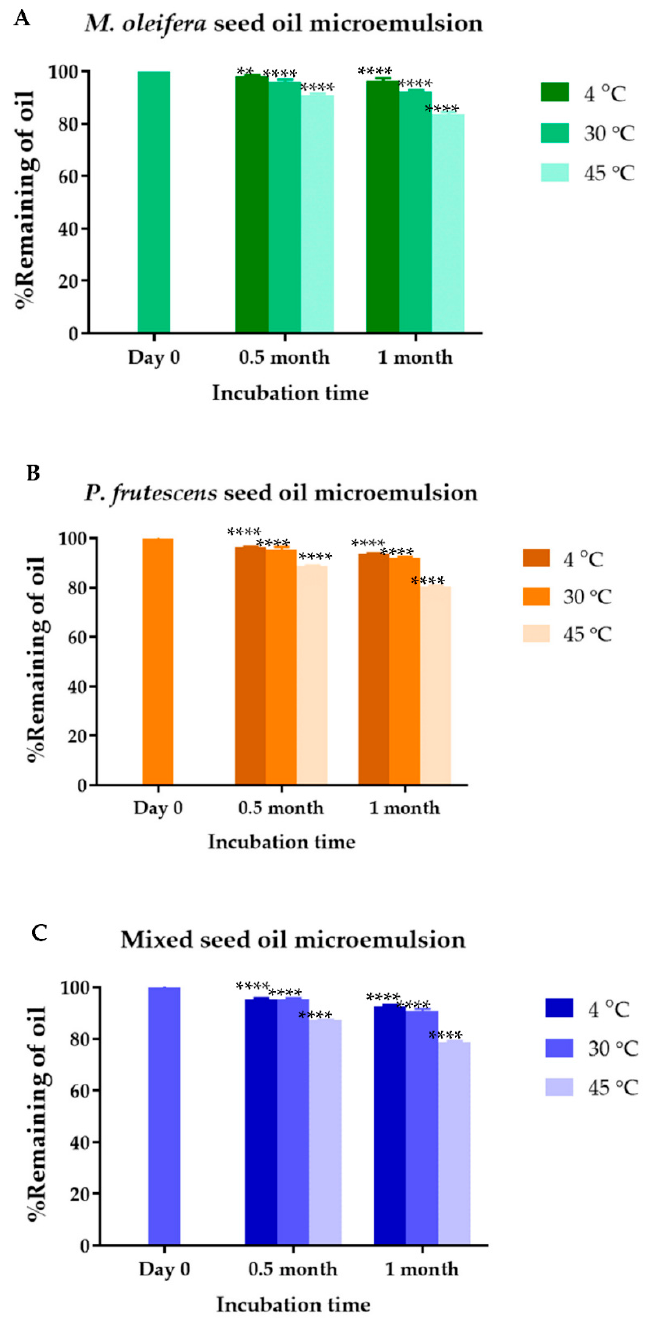
Figure 4. Chemical stability of oil in P. frutescens , M. oleifera , and mix seed oil microemulsions. Data represent mean ± SD from three experiments. ** indicates p < 0.01, and **** indicates p < 0.0001, compared with Day 0.